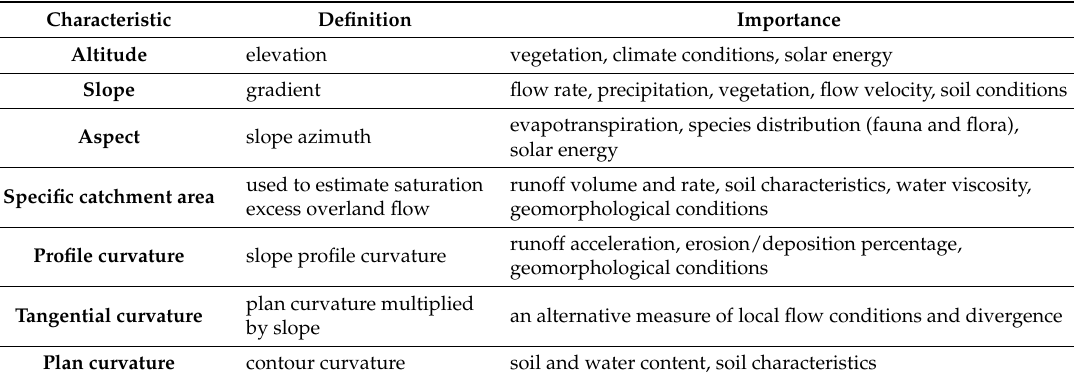
Table 2. Primary topographic attributes that were computed by terrain analysis from digital elevation model (DEM) data in this study. Sources: